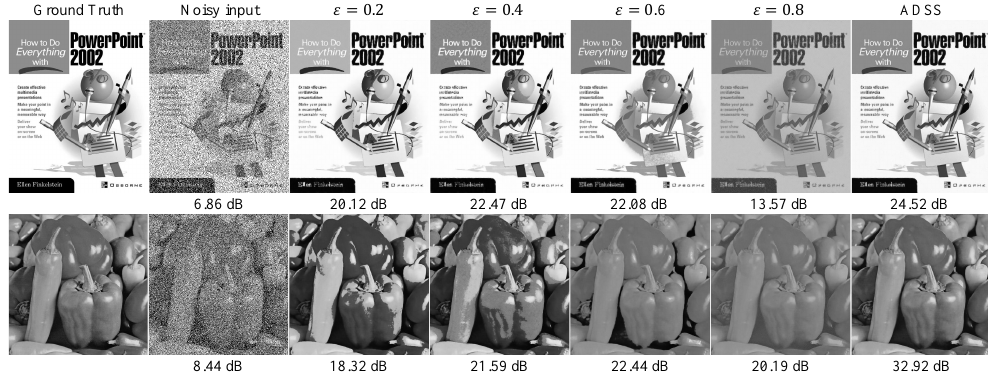
Figure 7. Effect of the loss clipping for various threshold values on salt-and-pepper noise (d = 50).